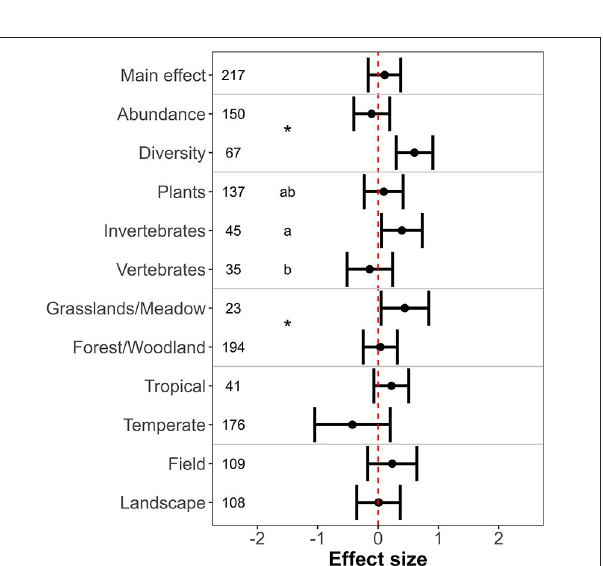
FIGURE 3 | Biodiversity levels in farmland with hedgerows as compared to natural habitat. X-axis indicates the mean effect size (standardized mean difference) ± 95% confidence interval. The dashed vertical red line shows the null effect. A confidence interval that overlaps this line means that the effects are not significant. Significant differences between levels of moderators are indicated by asterisks (two levels) and different letters (three levels),